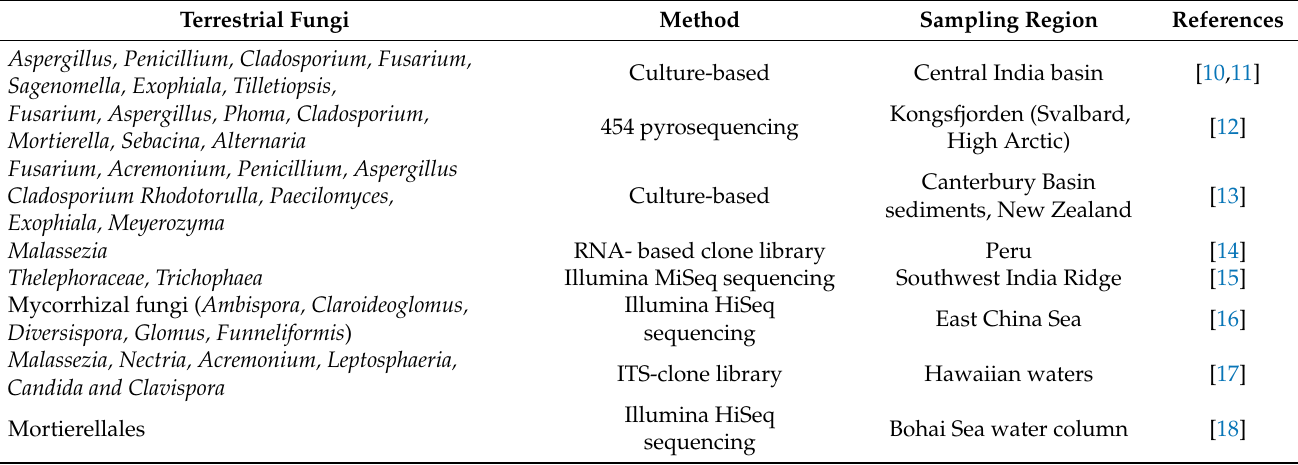
Table 1. List of fungi of terrestrial origin discovered through culture-based and molecular methods from different oceanic